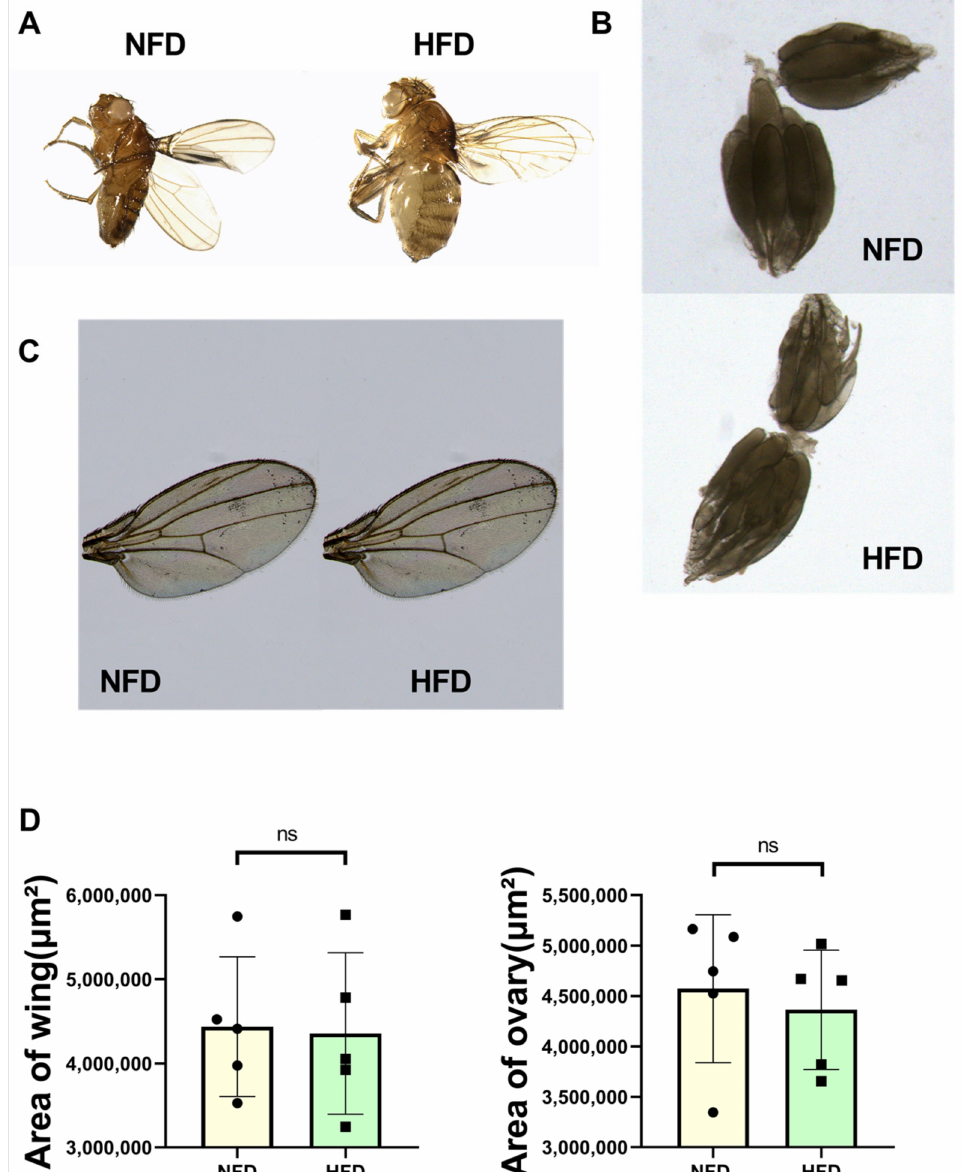
Figure 1. The w 1118 group and Hand > w 1118 group exhibited obesity after 5d of HFD feeding. ( A ) Morphological pictures of 10-day-old Drosophila under NFD and HFD feeding conditions, with HFD Drosophila being larger and having a protruding abdomen. ( B ) Photographs of ovaries of 10-day- old NFD and HFD flies. ( C ) Photographs of wings of 10-day-old NFD and HFD flies. ( D ) Comparison of wing size and ovary size between 10-day-old NFD and HFD flies (N = 5) using independent sample t